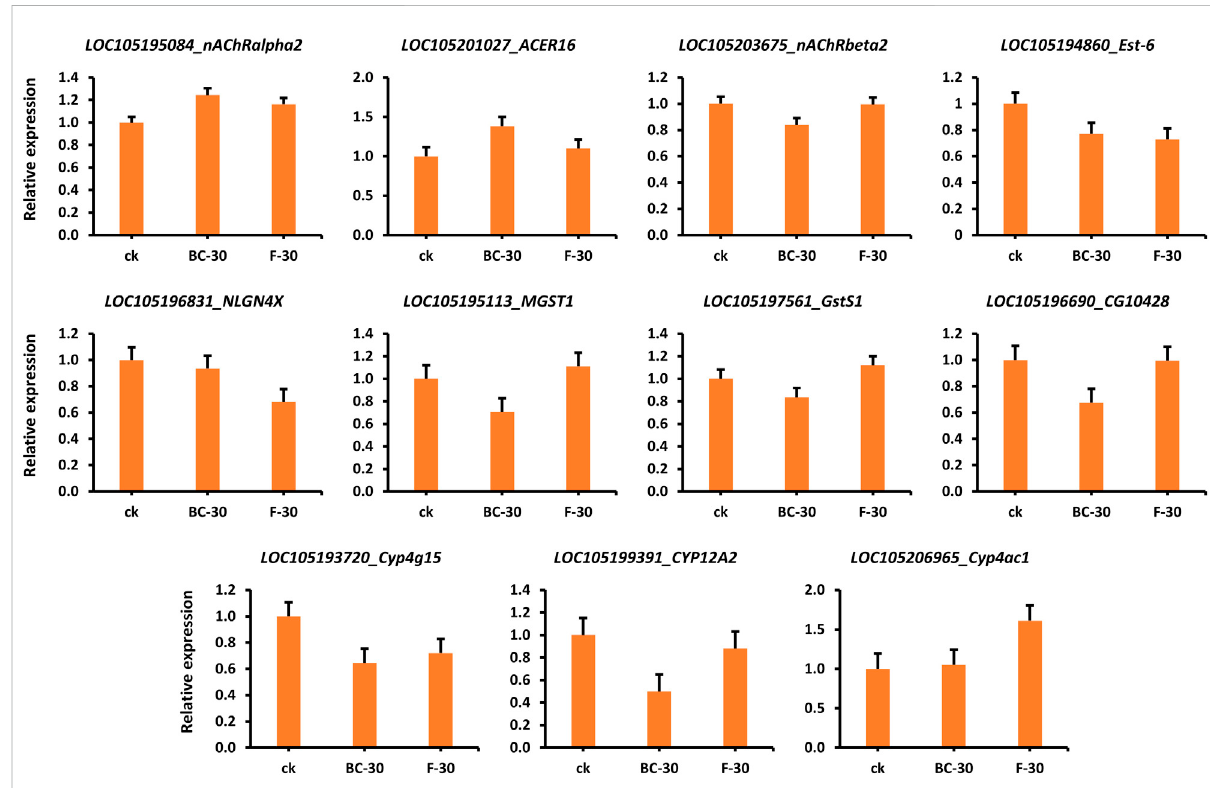
FIGURE 7 Validation of several related DEGs involved in the detoxi fi cation of beta-cypermethrin and fi pronil in Solenopsis invicta through